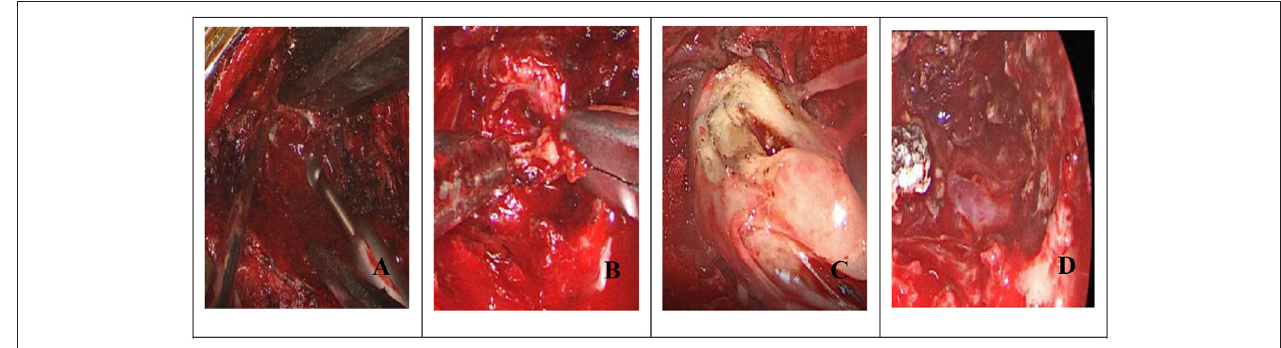
FIGURE 7 | (Dumbbell): (A) Endoscopic removal of hemilamellae; (B) Endoscopic intratumoral resection; (C) After shrinking the tumor to create a channel, carefully separate the tumor from upper and lower levels; (D) Tumor removal following endoscopic